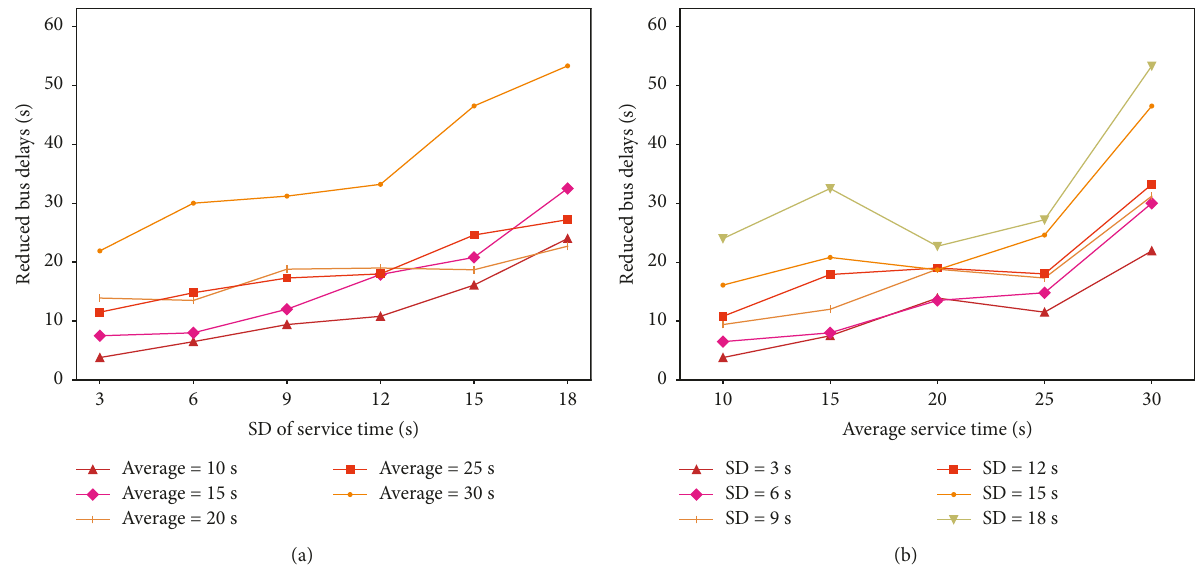
Figure 10: Impacts of service time on weighted bus delay: (a) SD of service time and (b) average service time.